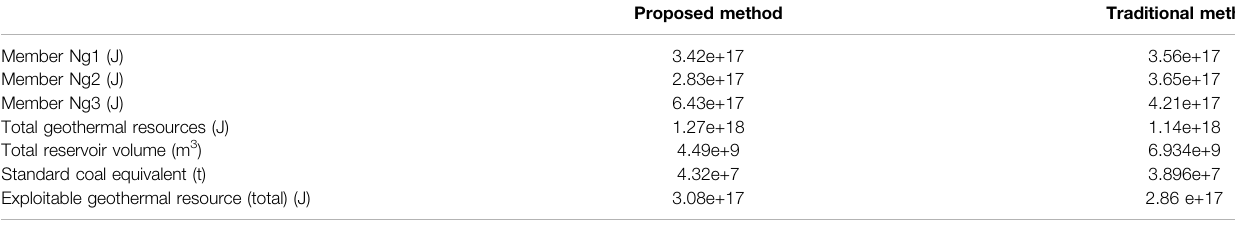
TABLE 3 | The geothermal resource calculation (Ng1 – Ng3), compared with the traditional volumetric method results.